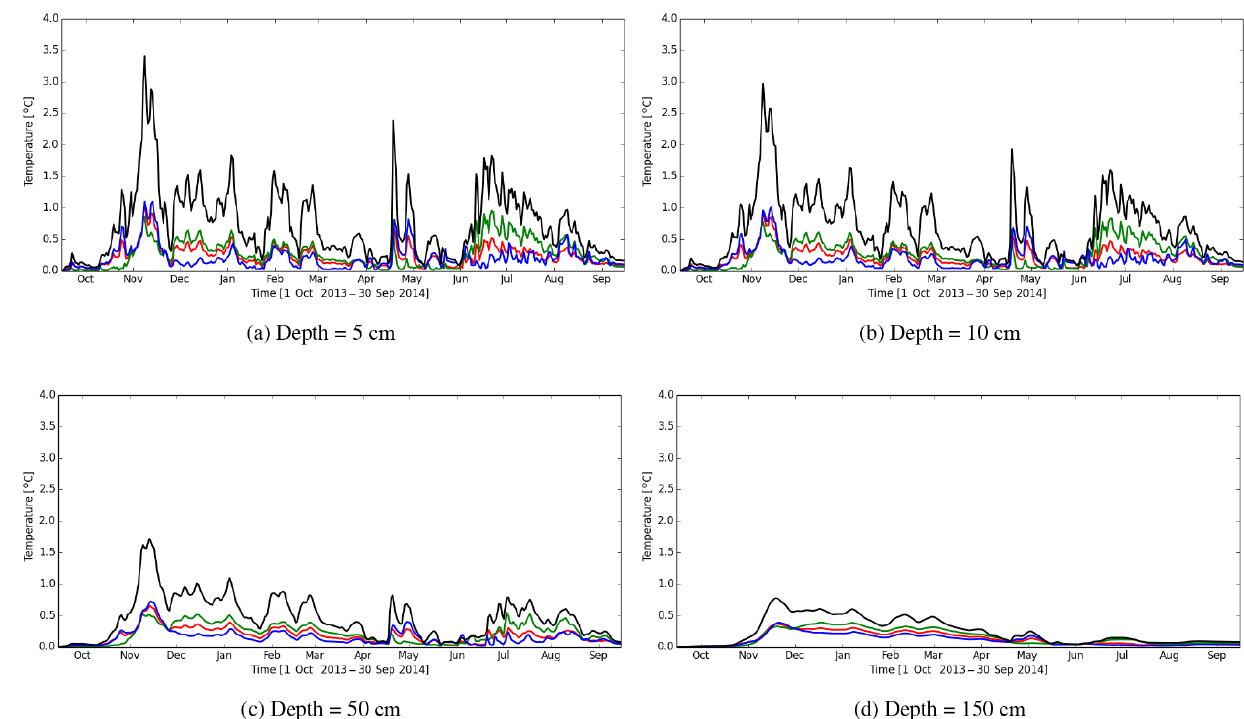
Figure E2. Spatiotemporal variability (standard deviation) in simulated soil temperature at Site C. Red, green and blue lines represent center, rim and trough respectively, and the black line represents the standard deviation across Site